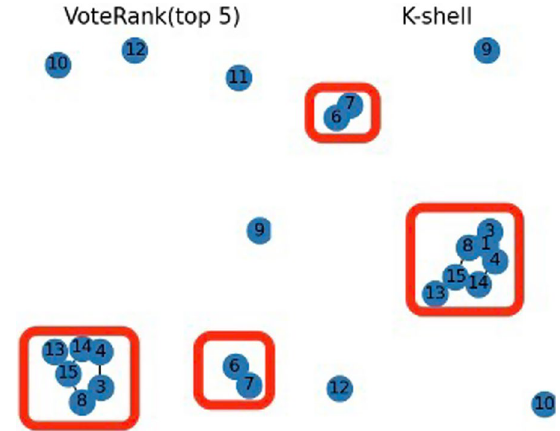
Fig. 3 TOP 3 nodes attack connectivity comparison figure b